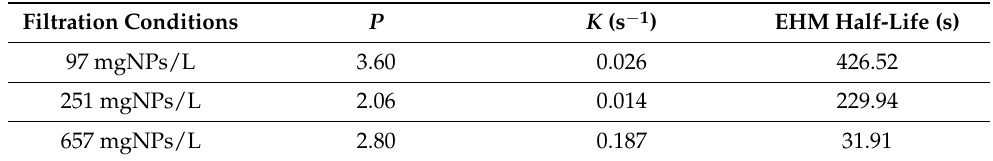
Table 16. EHM parameters for the regressions obtained in Example 6 at 0.4 bar and different nanoparticle concentrations.